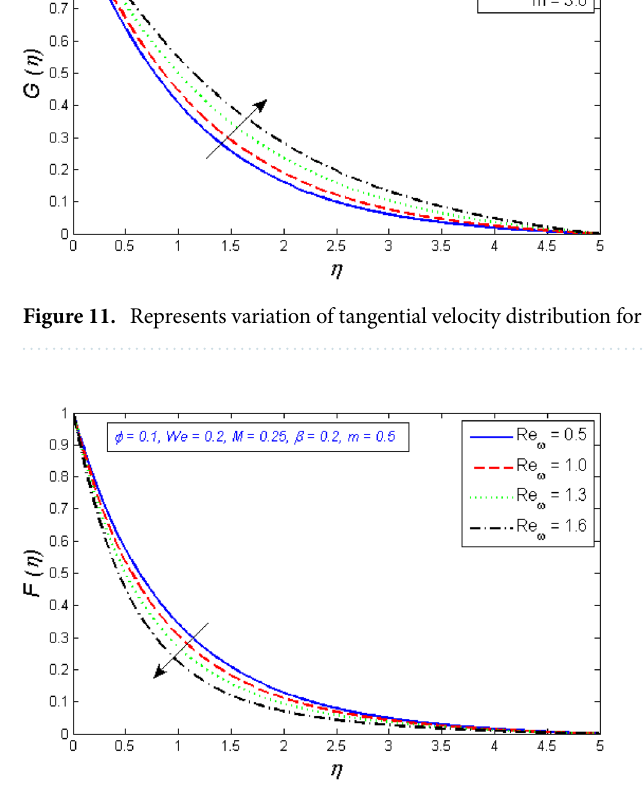
Figure 12. Represents variation of radial velocity distribution for several number of Local Reynolds number established on the disc angular velocity Re ω .